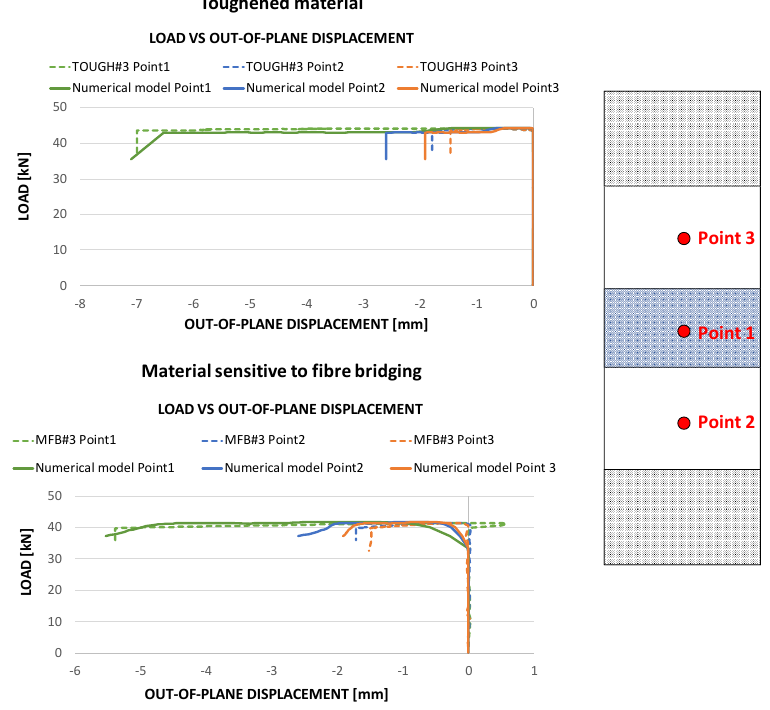
Figure 18. Compressive load as a function of the DIC measured out-of-plane displacements: comparison between experimental data and numerical results.